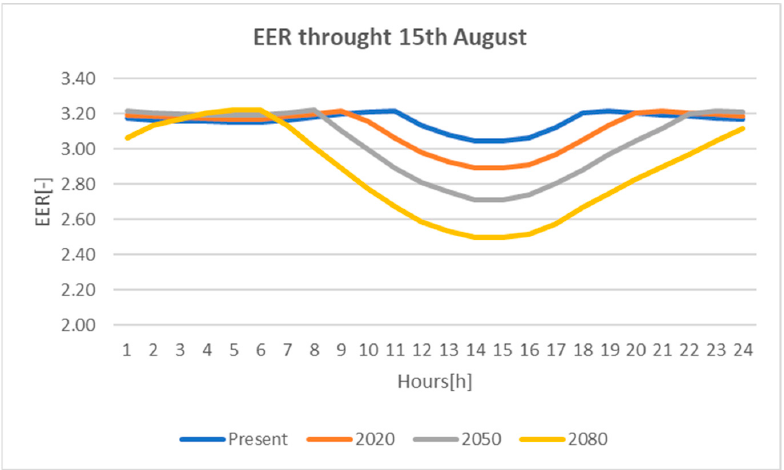
Figure 11. The EER through 15th of August for the present and the predicted future in Hurghada.